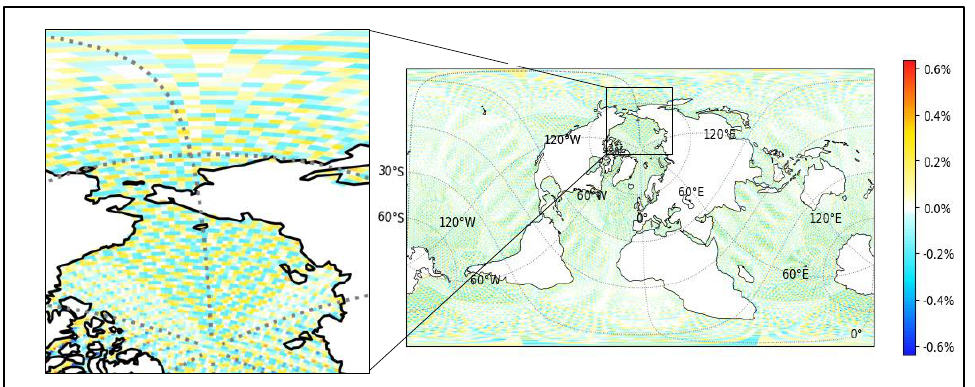
Figure 15. Misfit (%) on the target grid nogt for the icos-nogt second-order conservative remapping with FRACAREA normalisation for ESMF, with a zoom on the left.